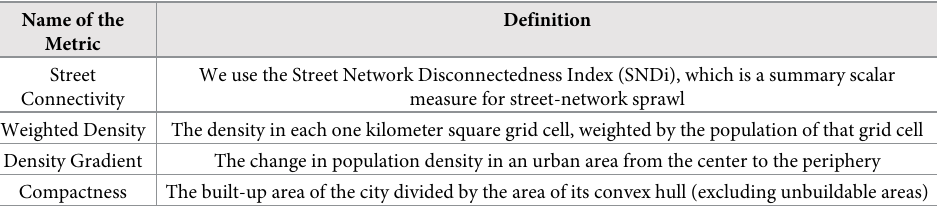
Table 1. Urban form metrics used in this research [12, 15, 17,